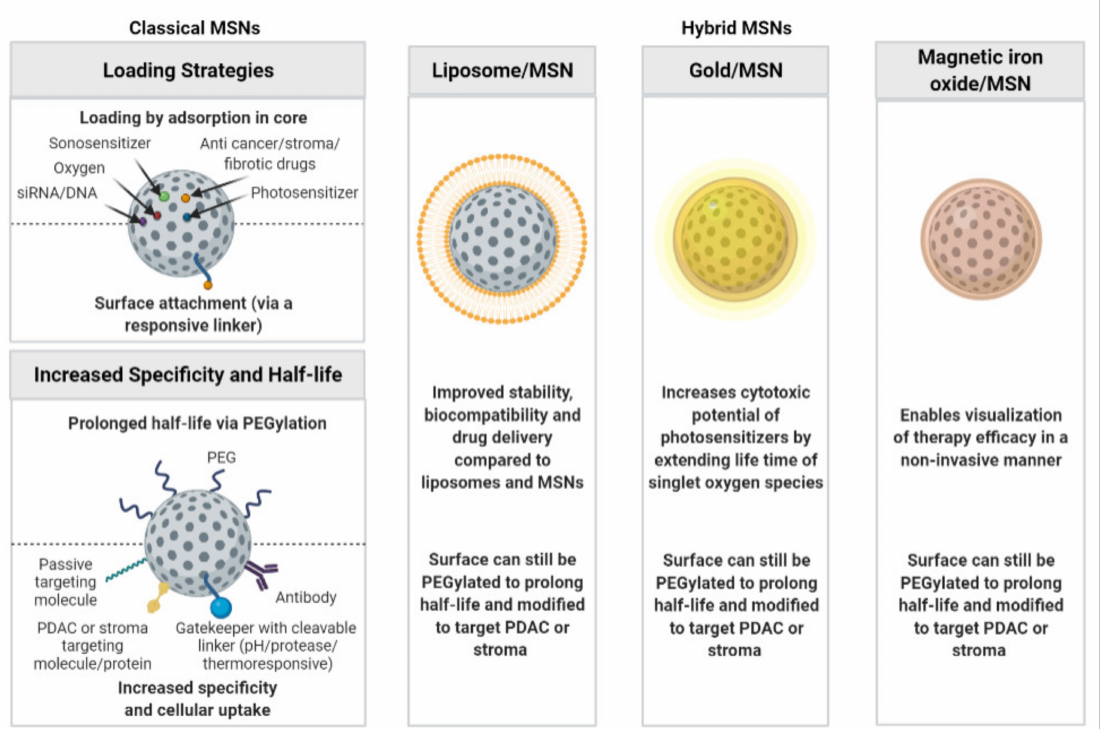
Figure 2. Diagram summarizing loading strategies of different molecules (siRNA/DNA, oxygen, sonosensitizer (e.g., IR780), anticancer drugs (e.g., gemcitabine, cisplatin, curcumin, irinotecan, paclitaxel, palbociclib, and oxaliplatin), anti-stroma drugs (e.g., TGF- β inhibitor), antifibrotic drugs (e.g., pirfenidone), photosensitizers (e.g., ZnPcOBP and methylene blue), methods to prolong half- life, increase specificity and cellular uptake (passive targeting molecules (e.g., polyethyleneimine), PDAC targeting molecules/proteins (e.g., folic acid, transferrin, urokinase plasminogen activator, V7 peptides, cyclosporine A, IGF1, c(RGDfE), and CCKBR aptamer), stroma targeting molecules (e.g., iRGD), gatekeeper with pH sensitive linkers (e.g., chitosan, disulfide bonds, and poly(D,L-lactide- co-glycolide) (PLGA)), gatekeepers with protease linkers (e.g., ADAM9-responsive linker capped with avidin, thermoresponsive gatekeeper (e.g., aliphatic azo group capped with β -cyclodextrin), antibodies (e.g., tMUC-antibody, GPC1-antibody, Cetuximab, anti-claudin 4, and anti-mesothelin), and hybrid